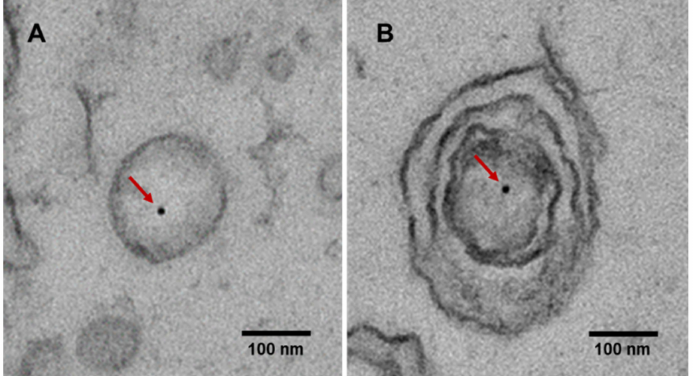
Figure 2. Detection of dsDNA in BALF EVs using immuno-EM. ( A ) Single vesicle and ( B ) multilayer vesicle. The solid black dots indicate DNA (indicated by red arrows). dsDNA—double-stranded DNA; BALF—bronchoalveolar lavage fluid; EV—extracellular vesicle; EM—electron microscopy.